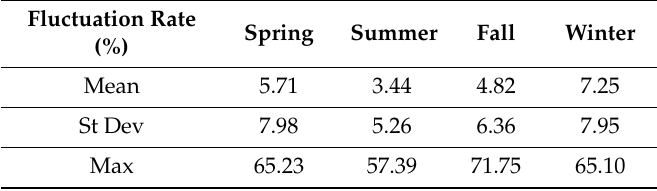
Table 2. Statistic of seasonal fluctuation rate of wind power outputs.